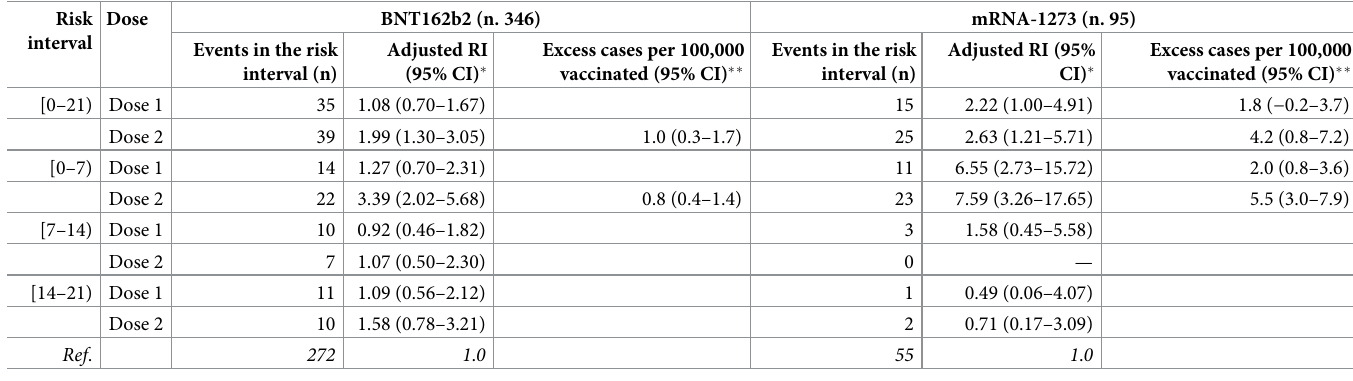
Table 2. Adjusted RI estimated by SCCS and excess cases per 100,000 vaccinated by vaccine product and risk intervals: 346 myocarditis/pericarditis events in the BNT162b2 and 95 events in the mRNA-1273 vaccinated population aged 12–39 years from 27 December 2020 to 30 September 2021. Risk Dose BNT162b2 (n. 346) mRNA-1273 (n. interval